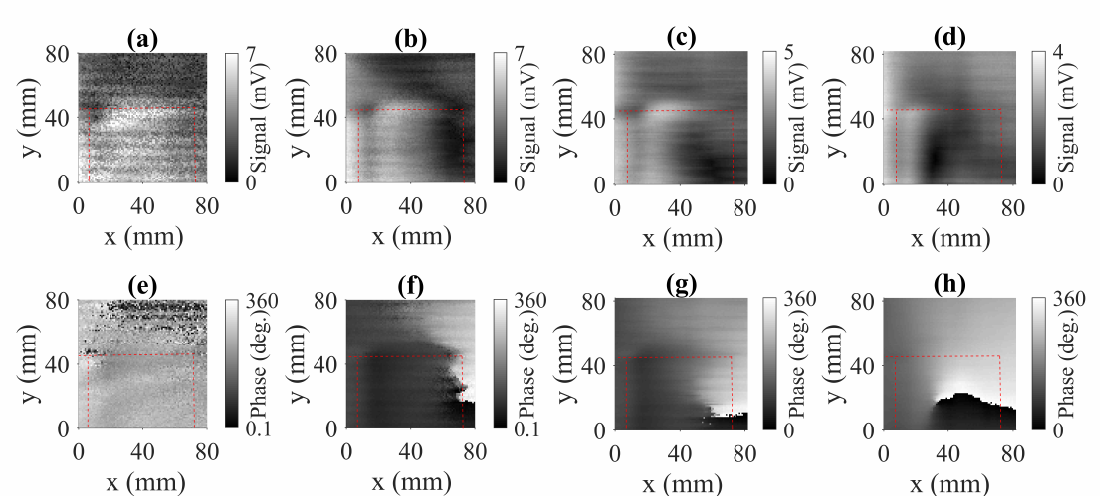
Figure 6. The change of the amplitude ( a – d ) and phase ( e – h ) of the rf signal recorded for a plate with a continuously changing thickness [shown by Figure 2d] for four values of the rf primary field frequency: ( a , e ) 0.6 kHz, ( b , f ) 1.35 kHz, ( c , g ) 2.26 kHz, ( d , h ) 10 kHz. The red dashed line marks a position of the edge of the recess on the under side of the plate. The thickness of the plate gradually increases from 1mm at x = 23mm to 6mm at x = 64mm; and has a constant thickness along y = 0mm to y =